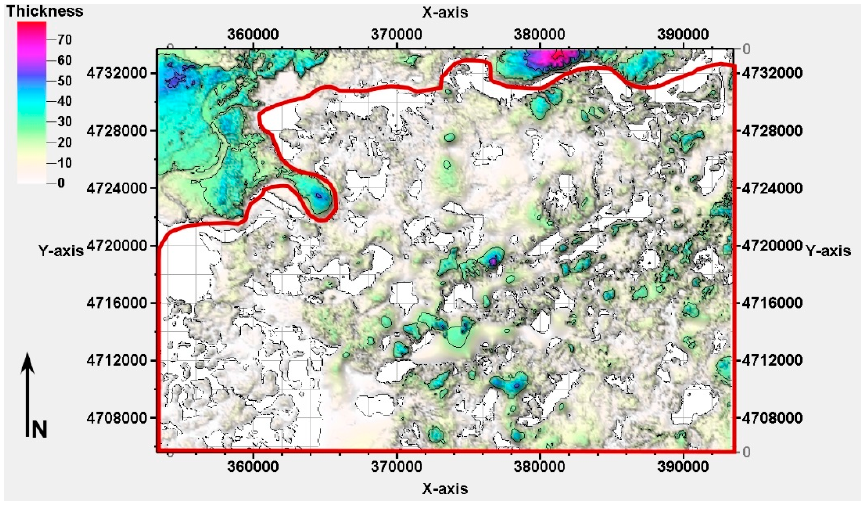
Figure 8. Isopach map of the New Berlin Member, thickness is in meters. The study area is outlined in red.